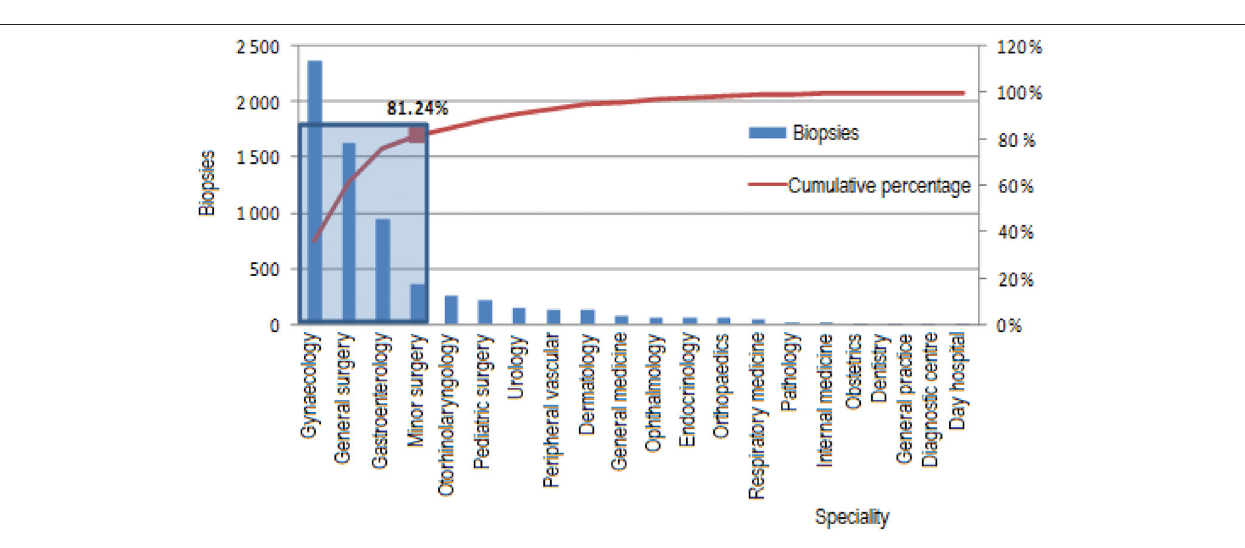
FIGURE 4 | Pareto chart for the number of biopsies according to